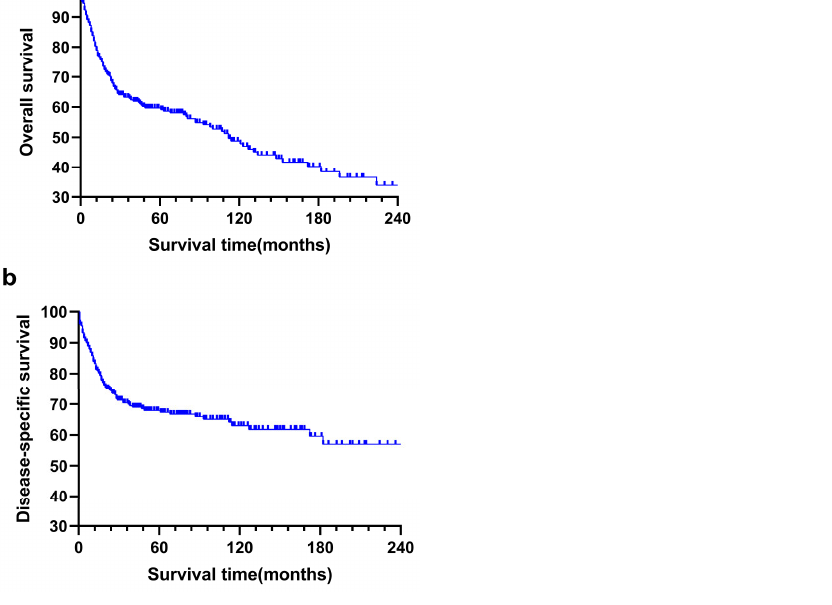
Figure 1. Kaplan–Meier curve analyses of the overall survival (OS, ( a ), p < 0.001) and disease-specific survival (DSS, ( b ), p < 0.001) in primary bile duct and ampullary neuroendocrine neoplasms pa- tients.